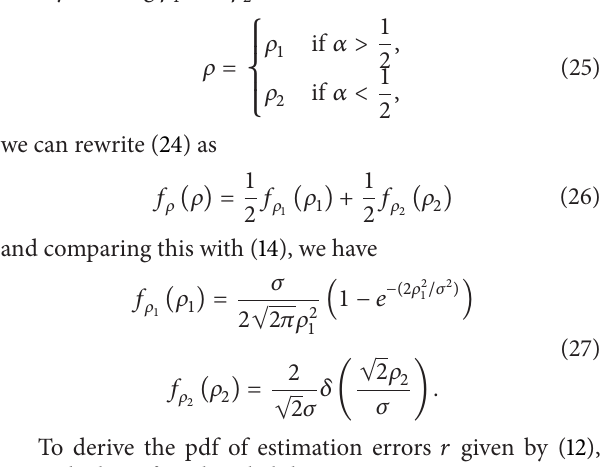
Figure 4: The shape of the integrand of the first integral in (14) for 𝜎 2 = 1 . and by defining 𝜌 1 and 𝜌 2 to